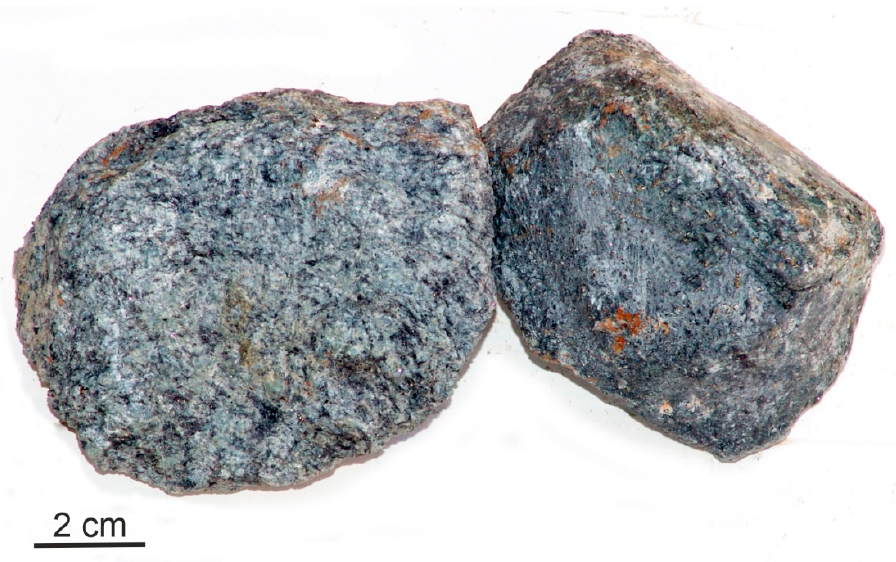
Minerals 2022 , 12 , x FOR PEER REVIEW Figure 10. A general view of sample 242 with vein ‐ disseminated mineralization. Figure 10. A general view of sample 242 with vein-disseminated mineralization.